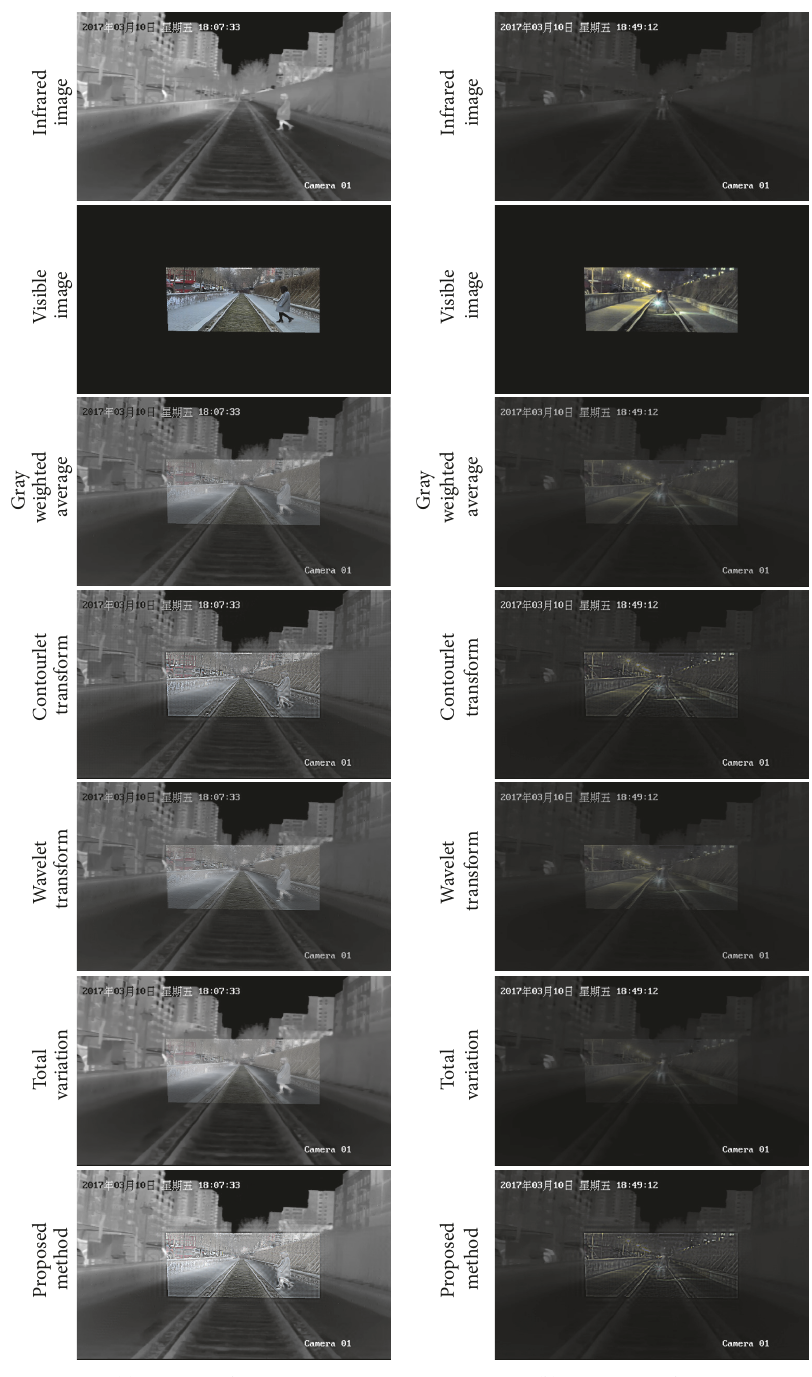
Figure 11: Comparison of visual quality of source and fused images of various methods at daytime and night.